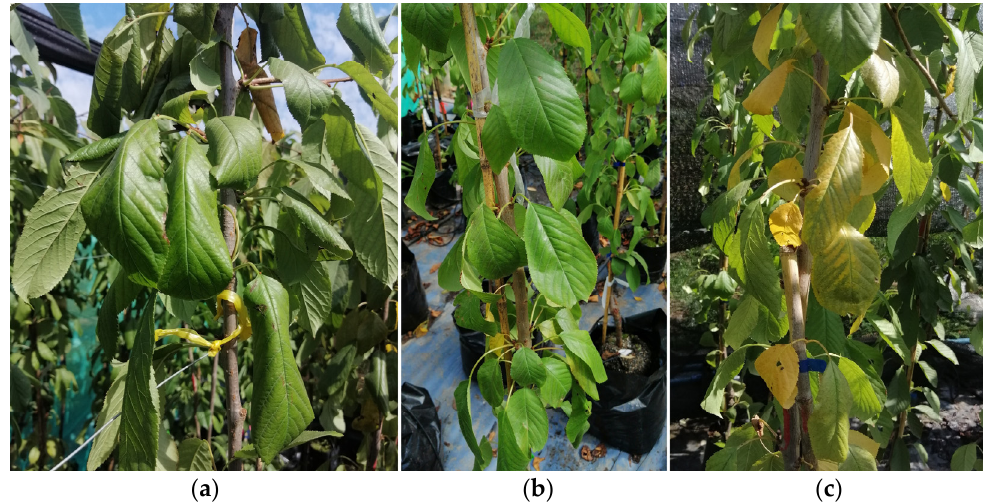
Figure 1. Visual symptoms of sweet cherry leaves with three concentrations of soil boron availability, deficient ( a ), adequate ( b ), and toxic ( c ) (0.04, 1.10, 3.75 mg kg − 1 ), respectively.